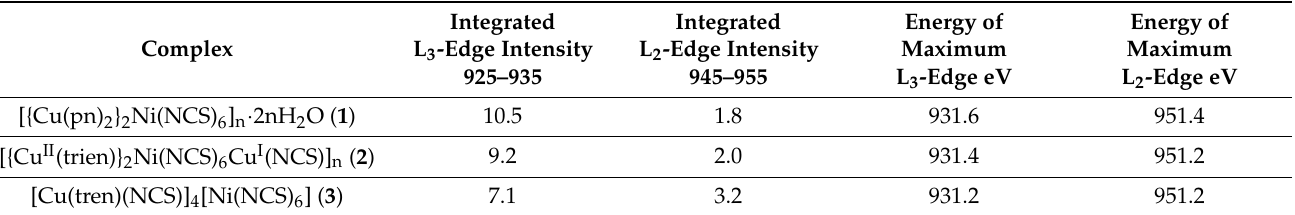
Figure 8. Normalized Cu L-edge absorption spectra for [{Cu(pn) 2 } 2 Ni(NCS) 6 ] n · 2nH 2 O ( 1 ) ( a ), [{Cu II (trien)} 2 Ni(NCS) 6 Cu I (NCS)] n ( 2 ) ( b ) and [Cu(tren)(NCS)] 4 [Ni(NCS) 6 ] ( 3 ) ( c ). Table 5. Integrated intensities and energies of maximum for Cu L 3 -edge and L 2 -edge peaks for 1 , 2 and 3.